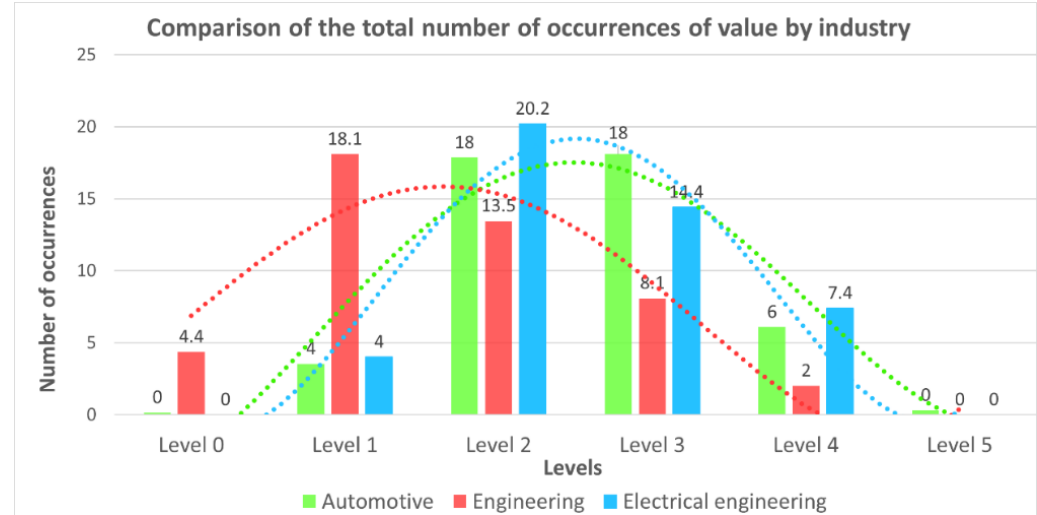
Figure 5. Comparison of the total number of occurrences of values for automotive, mechanical engineering and electrical engineering industries.